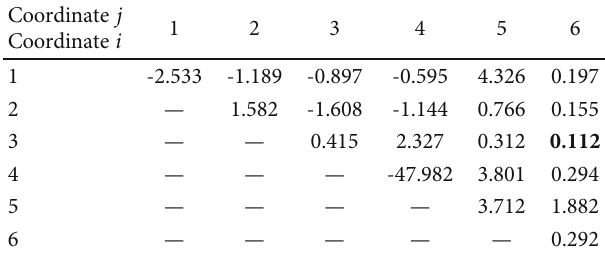
after the mass 34 ij ð opt Þ